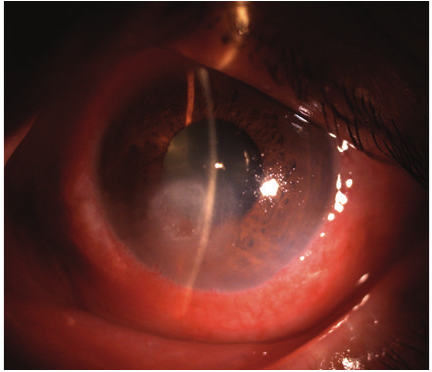
Figure 4: Day 16 since initial examination (Day 5 on Voriconazole).